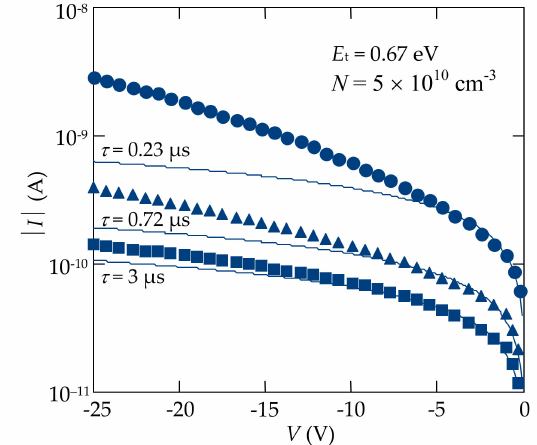
Figure 9. Comparison of the experimental (symbols) and calculated according to the Sah–Noyce– Shockley theory (solid lines) results of the reverse dark I-V characteristics of the In/CdTe/Au diode structures before (circles) and after (triangles and squares) irradiation from the In electrode side by nanosecond pulses of a KrF excimer laser with energy densities of 90 J/cm 2 (triangles) and 120 J/cm 2